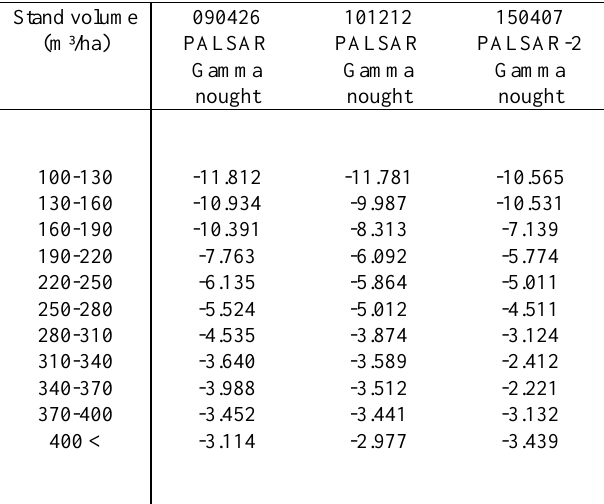
Table 2. Gamma-nought values for the stand volume over field measurements in 2009